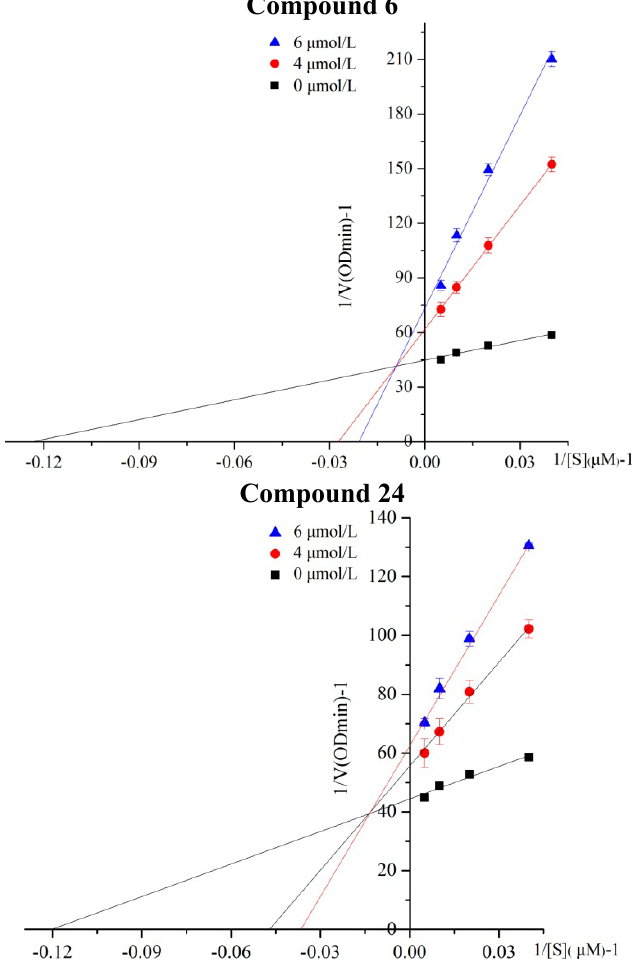
Figure 1. Lineweaver–Burk plots for inhibition of compound 6 and compound 24 against aldehyde dehydrogenase 1 (ALDH1) for the catalysis of